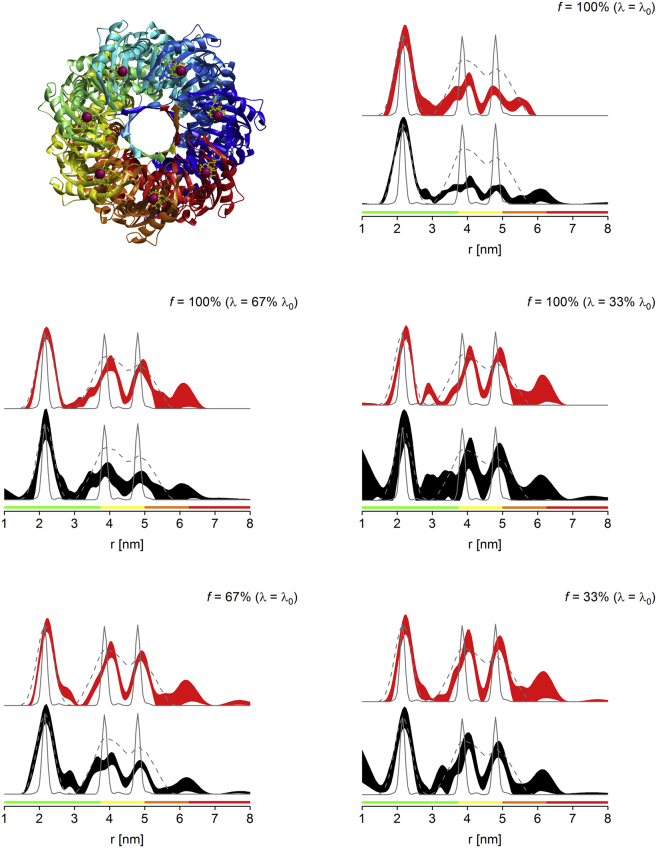
MscS S196R1 PELDOR distance distributions obtained for fully labeled protein (top right), λ-reduced fully labeled protein (middle panel, left, λ = 67% λ0; right, λ = 33% λ0), and sparsely labeled protein (bottom panel, left, f = 67%; right, f = 33%). Depicted are the 2σ confidence intervals as black and red areas for nonscaled and power-scaled data, respectively. Predicted distance distributions from MMM2015.1 and MtsslWizard are shown as gray lines (solid and dashed, respectively). The bottom color bars represent reliability ranges for the distance distributions (8) (green, shape reliable; yellow, mean and width reliable; orange, mean reliable; red, no quantification possible). See Supporting Material for raw PELDOR data and processing. (Top left) Shown here is the MMM model of fully labeled protein. To see this figure in color, go online.